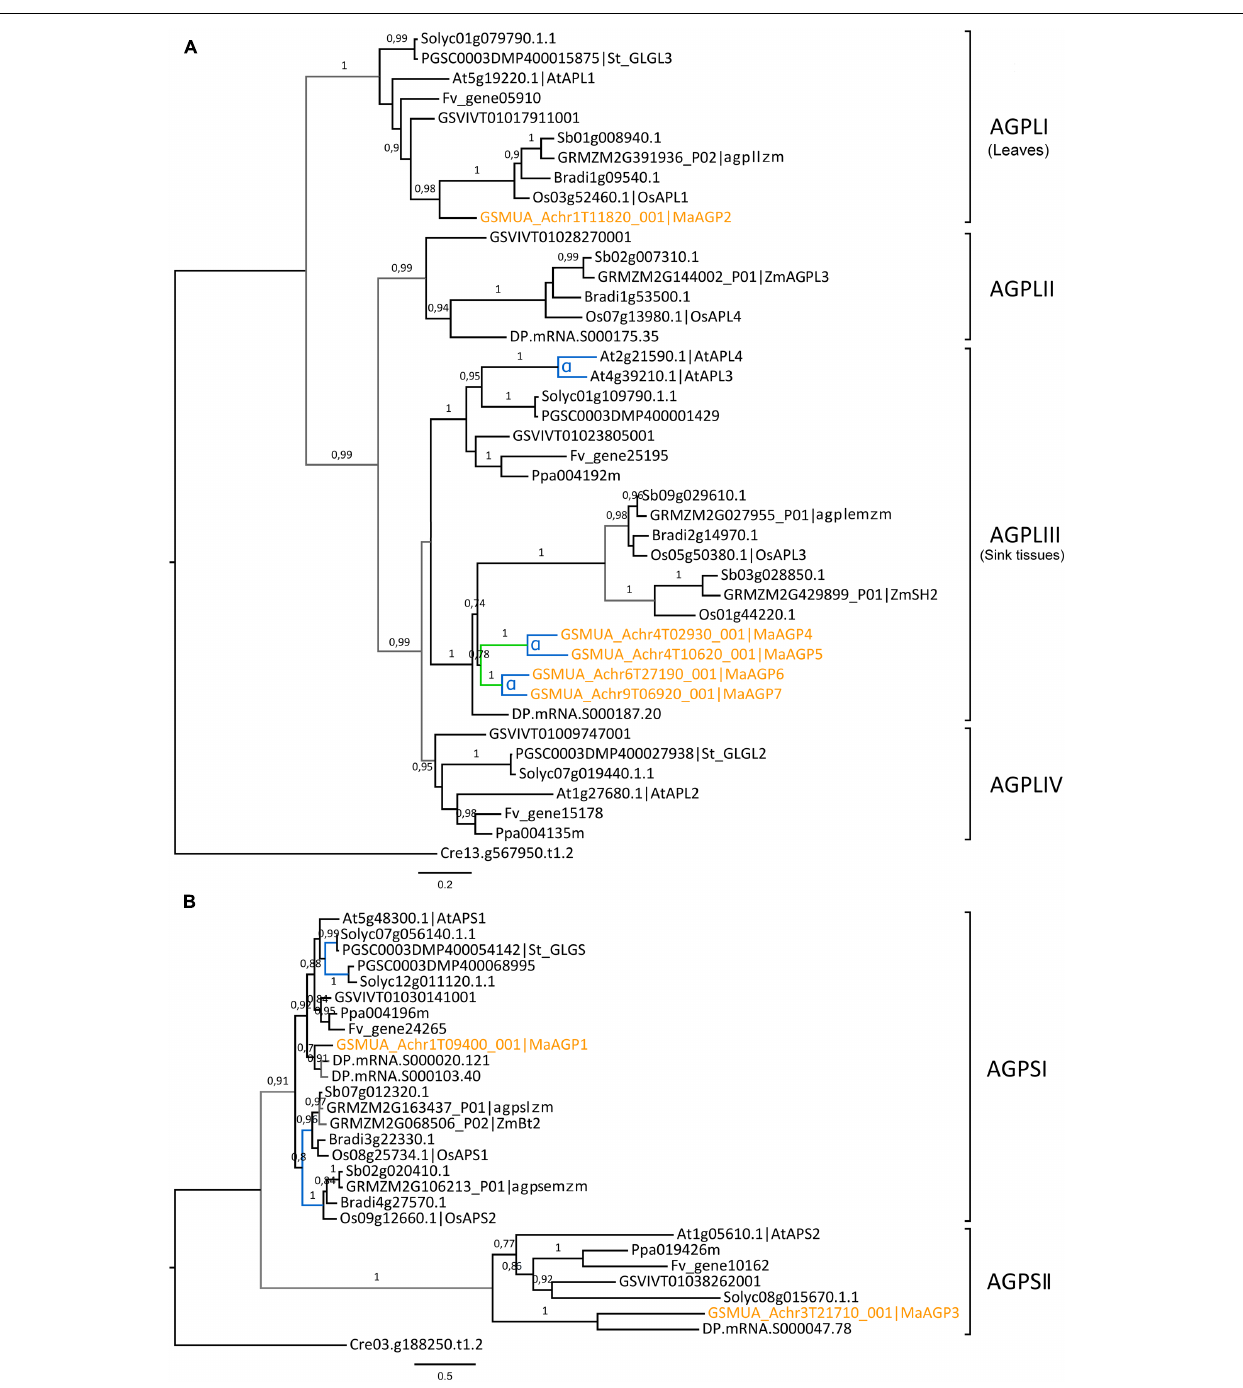
Frontiers in Plant Science |